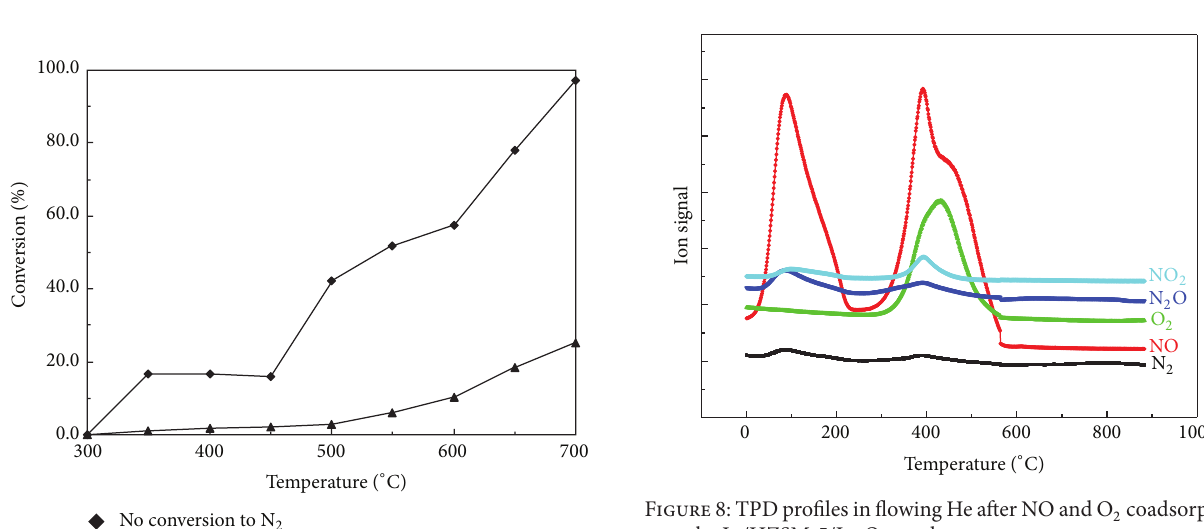
Figure 5: Conversion of the NO to NO 2 and N 2 as a function of reaction temperatures over In/HZSM-5/In 2 O 3 . Feed gas: 0.25% NO, 2.0% O 2 , and the balance of He; GHSV = 3600 h −1 .